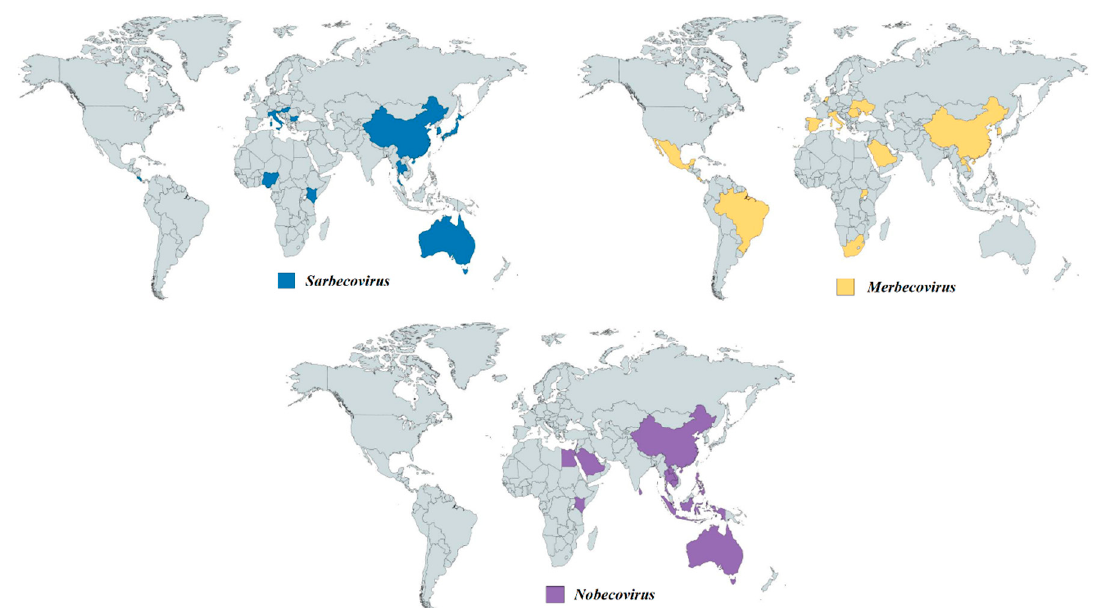
Figure 5. Geographical distribution of bat CoVs from the genus Betacoronavirus . Each colored region represents the country which reported the discovery of bat CoV from different sub-genera. Navy-blue regions represent the countries which discovered bat CoVs from Sarbecovirus . Yellow regions represent the countries which discovered bat CoVs from Merbecovirus . Purple regions represent the countries which discovered bat CoVs from Nobecovirus .